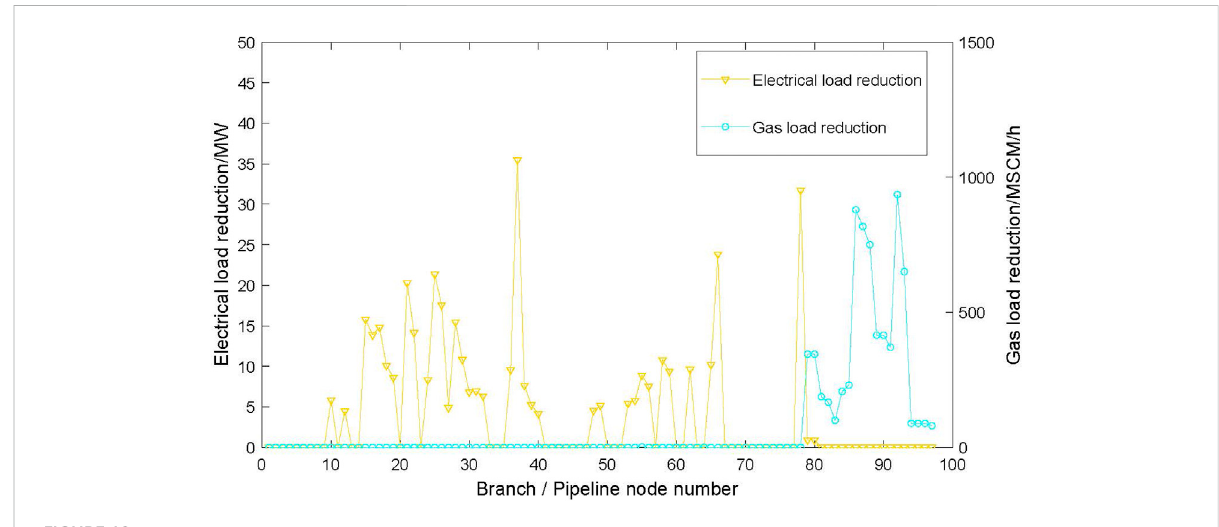
FIGURE 10 Reduction of electrical load and gas load under cyber attack.